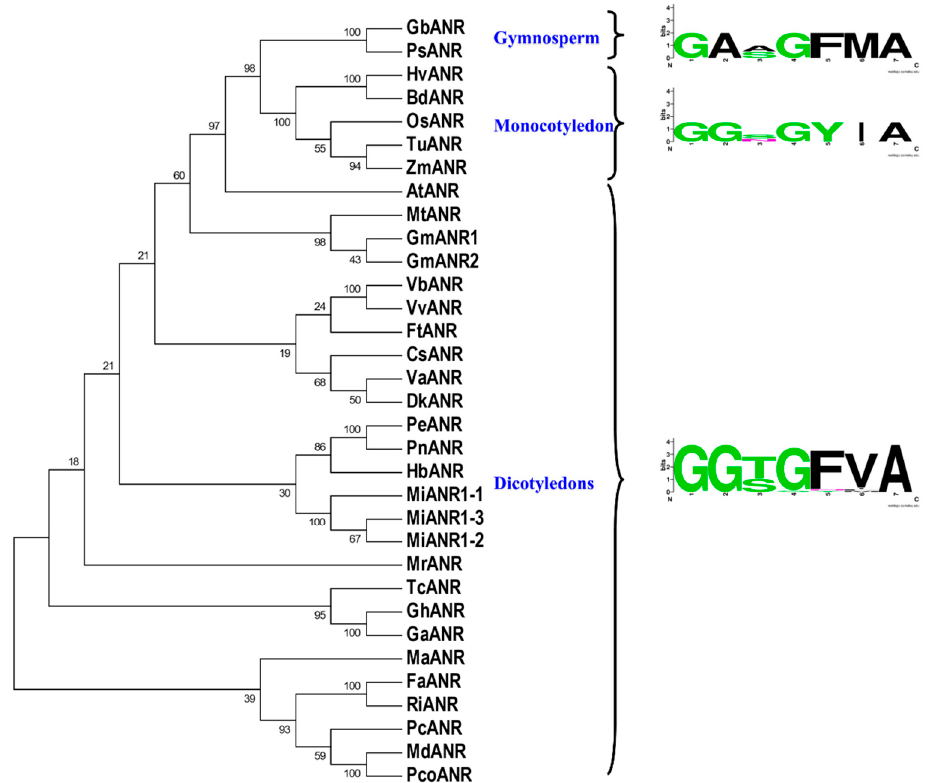
Figure 3. An unrooted phylogenetic tree with amino acid sequences of ANR homologs. Protein Alignment was performed by using ClustalW. The phylogenetic tree was constructed using